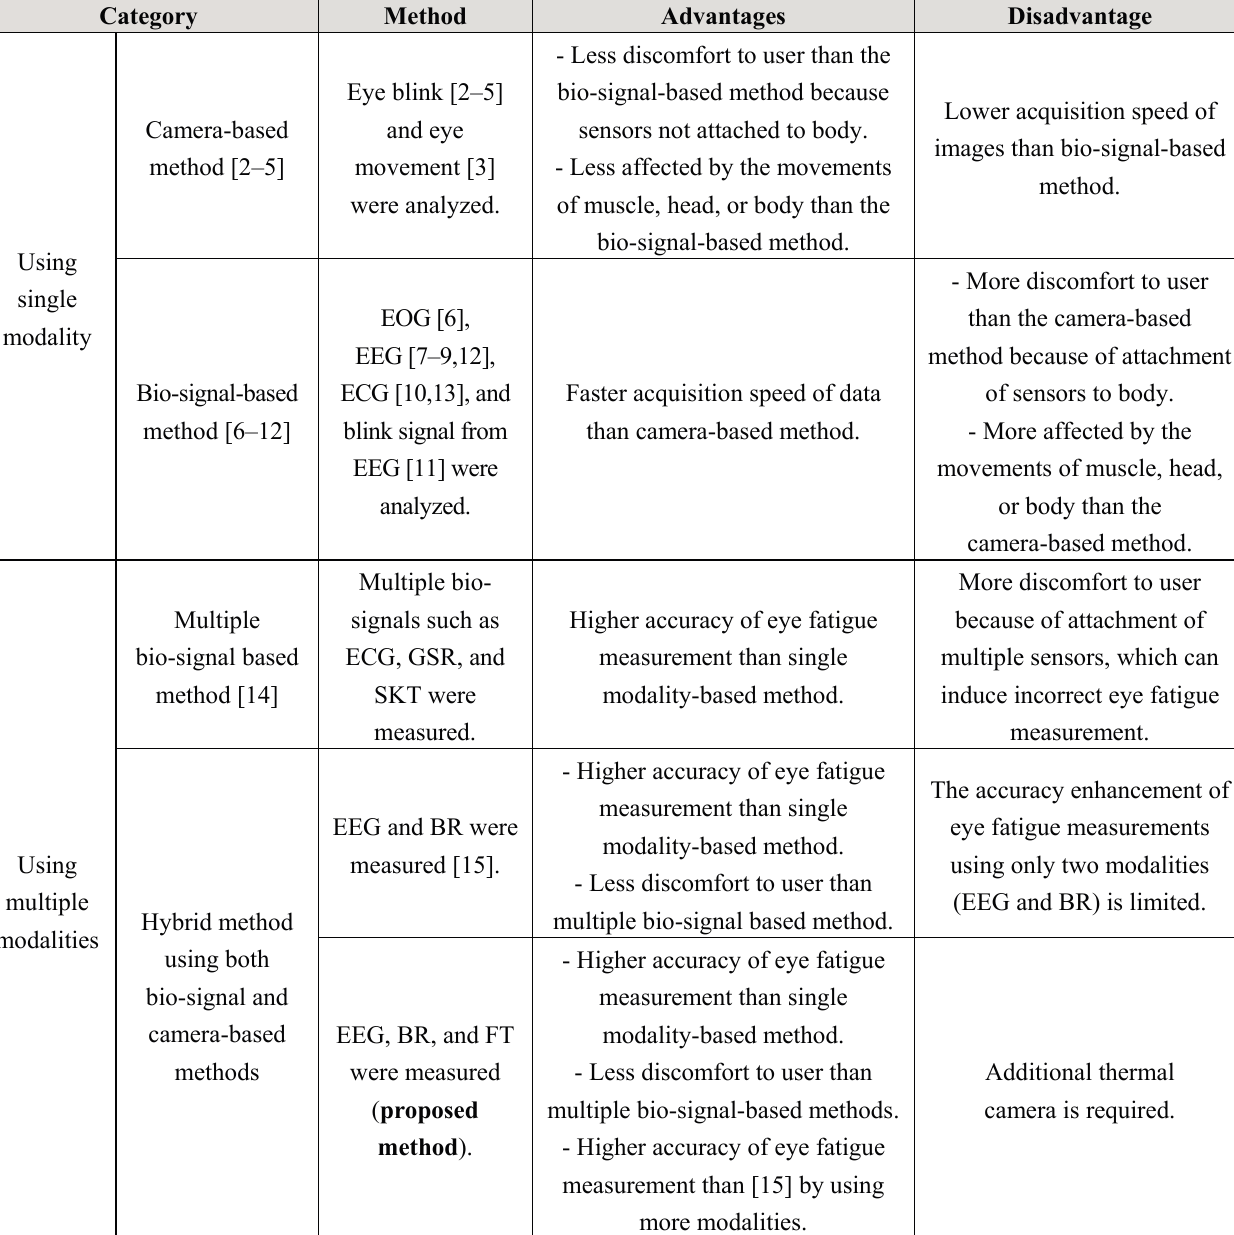
Table 1. Summarized comparisons of previous and proposed methods used to measure eye